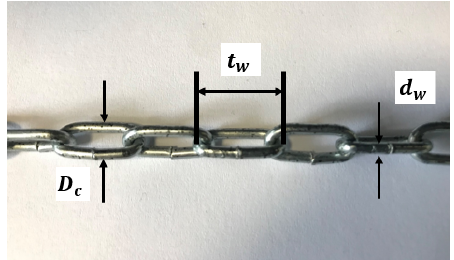
Figure 2. Principal dimensions of the selected